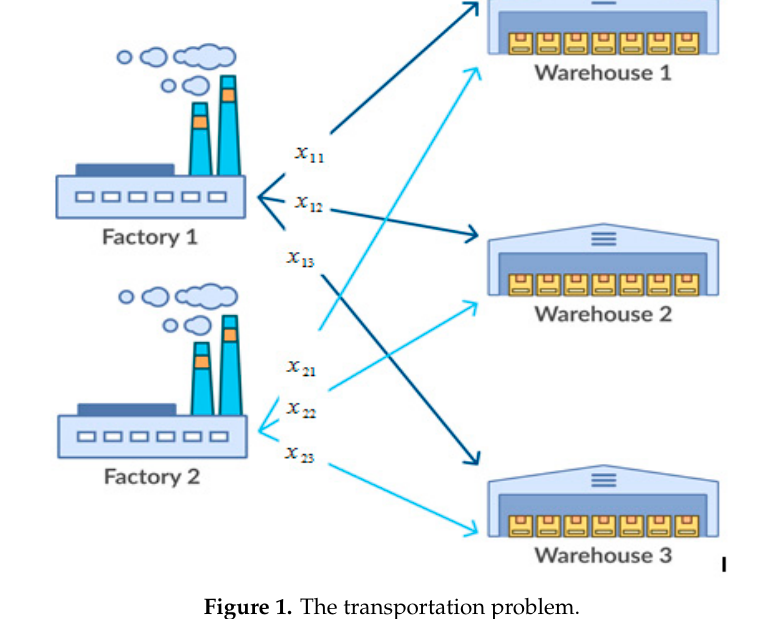
Figure 1. The transportation problem. Table 1. Transportation problem